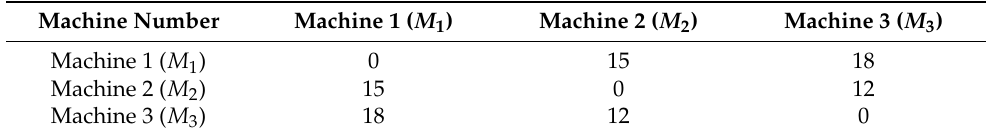
Table 2. The transportation times of AGV between machines (unit: